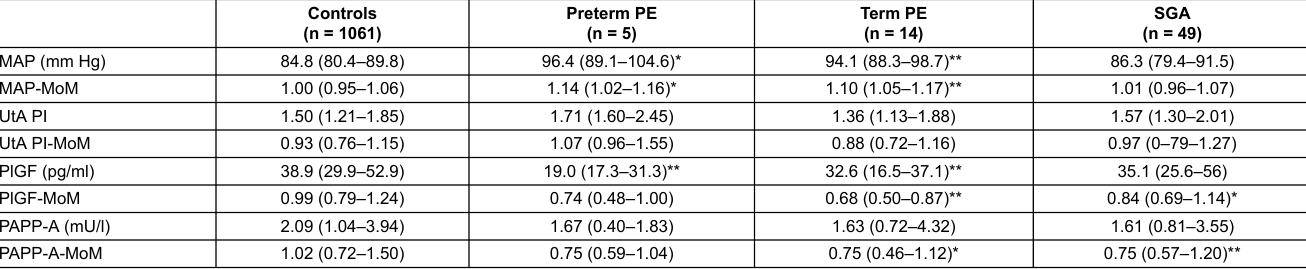
Table 3: Median and interquartile range of individual screening parameters and their multiple of the medians in uneventful pregnancies compared with preterm preeclampsia, term preeclampsia and delivery of infant small for gestational age. Controls Preterm PE (n = 1061) (n =